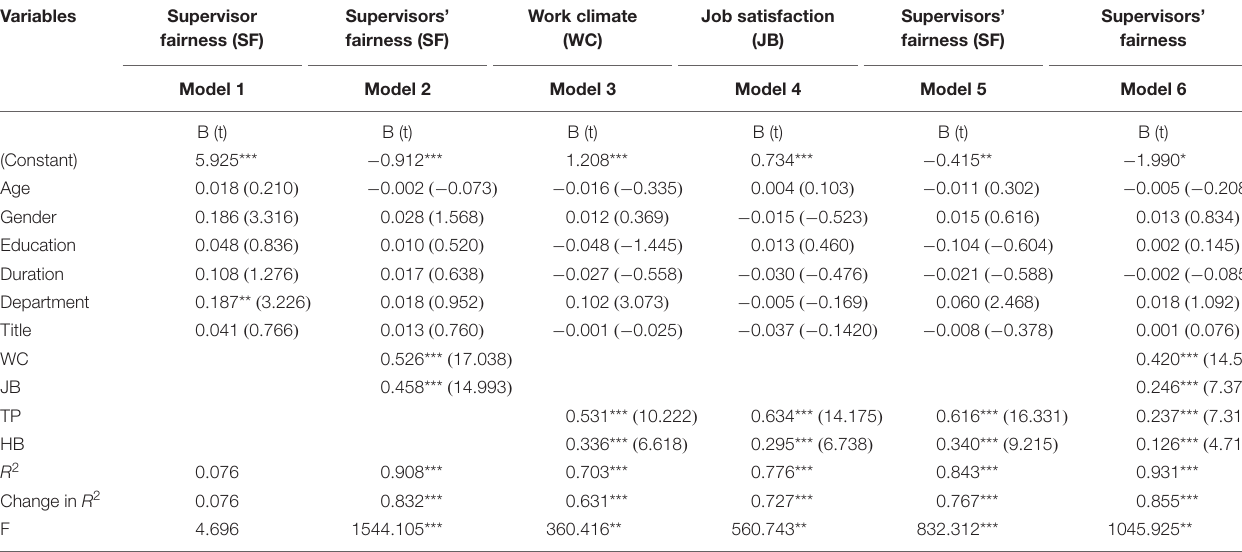
TABLE 3 | Hypotheses testing with the hierarchical regression analysis to indicate the relationships between the variables and the mediating effects of work climate on the relationship between supervisors’ fairness and task performance, and job satisfaction on supervisors’ fairness and helping behavior.